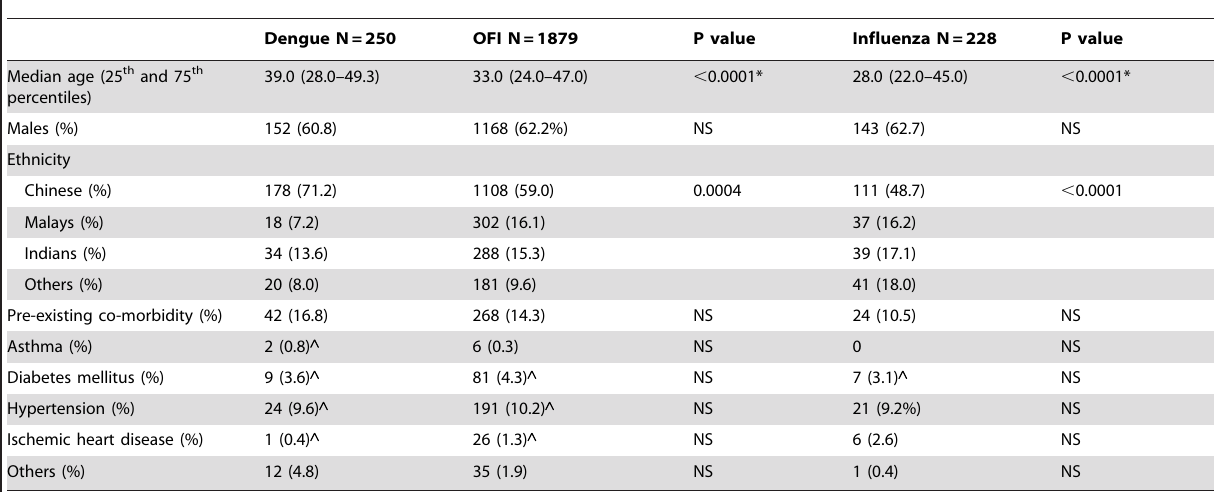
Table 2. Demographics of the dengue, OFI and influenza patients enrolled into the study.